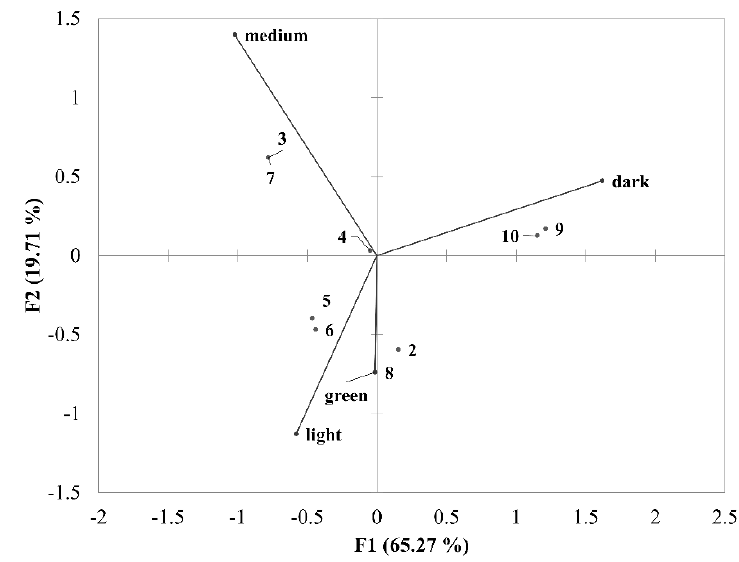
Figure 7. Correspondence analysis run on the data presented by Table 2. Numbers denote the number of times YSI was over the cut value.